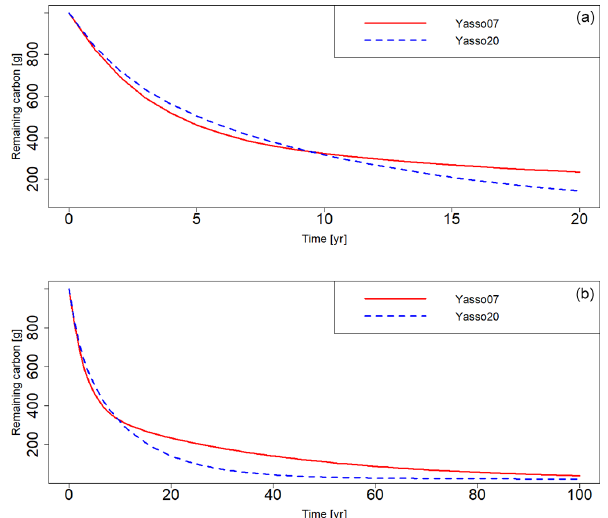
Figure 6. The remaining decomposing carbon for a hypothetical straw litter in Hyytiälä, Finland, climate conditions when simulated with Yasso07 (solid red) and Yasso20 (dashed blue) with a (a) 20- year and (b) 100-year time